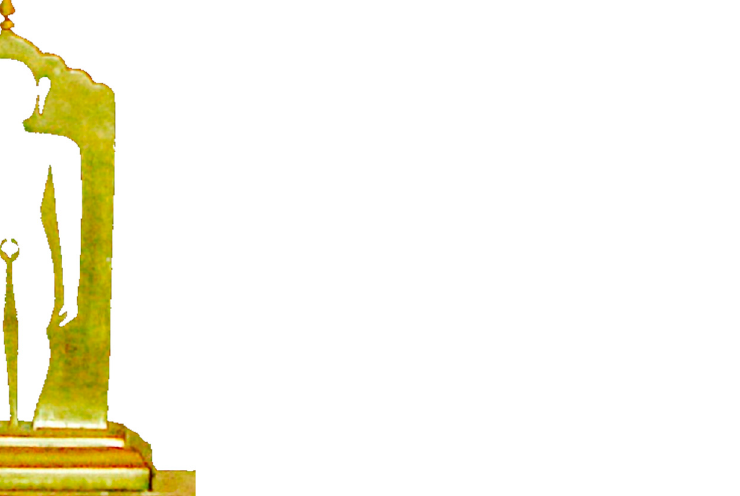
Figure 6. CC BY 2.5 by Yann (Wikimedia Commons). Jain representation of a siddhi —a liberated ( mok ṣ a ) being.